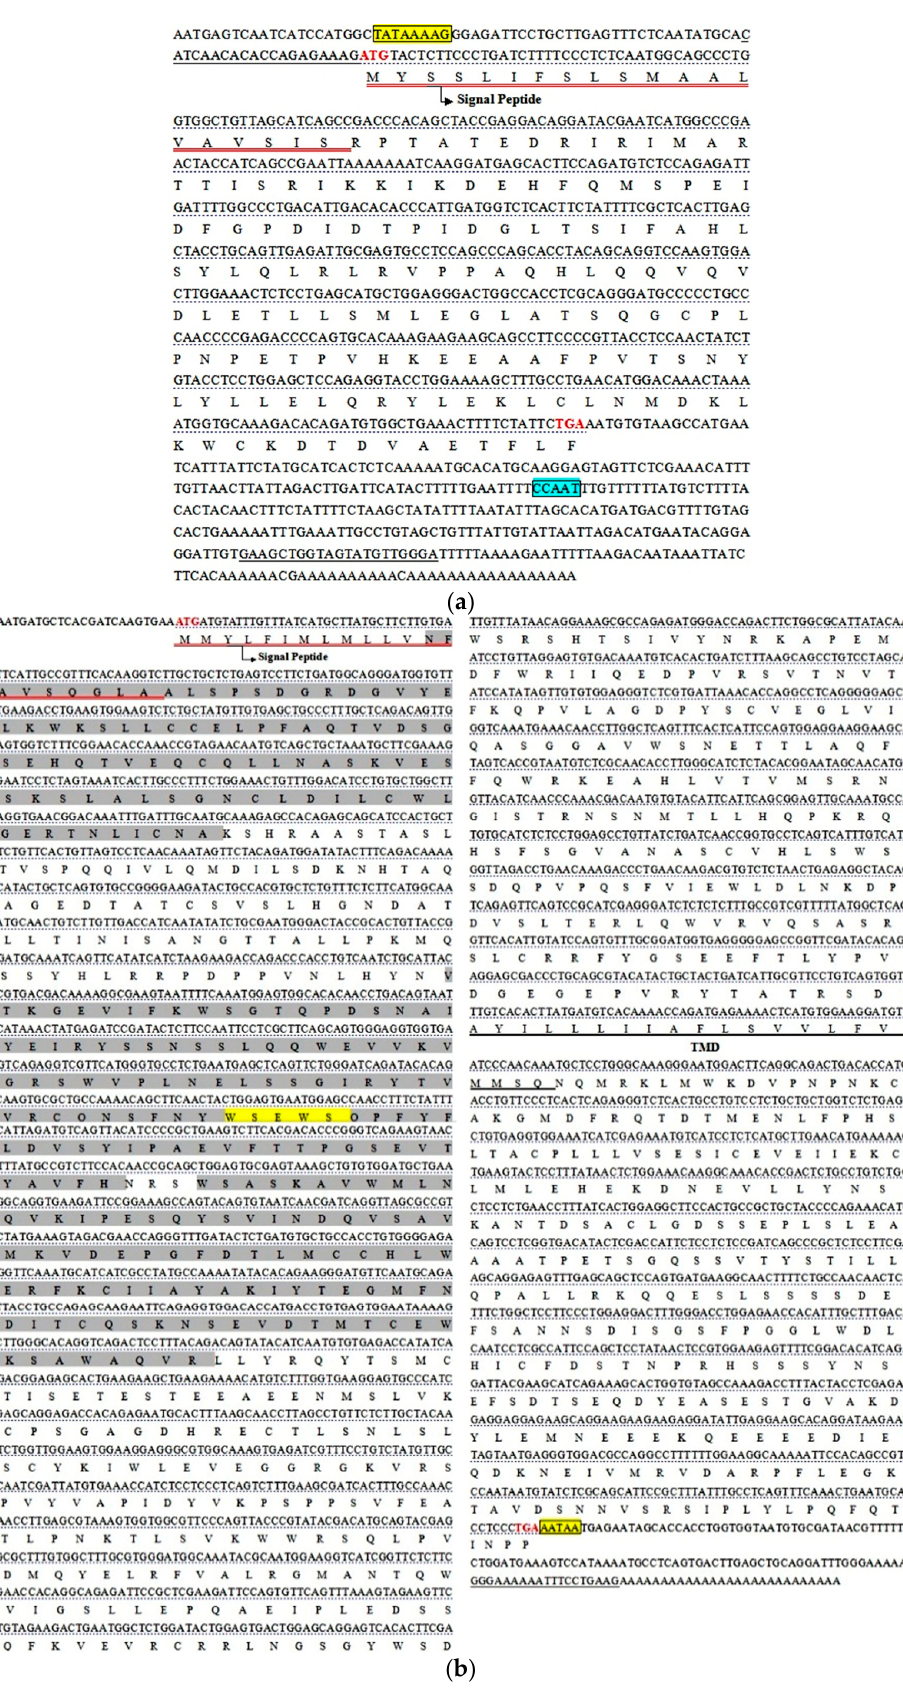
Figure 1. Cont. Figure 1.